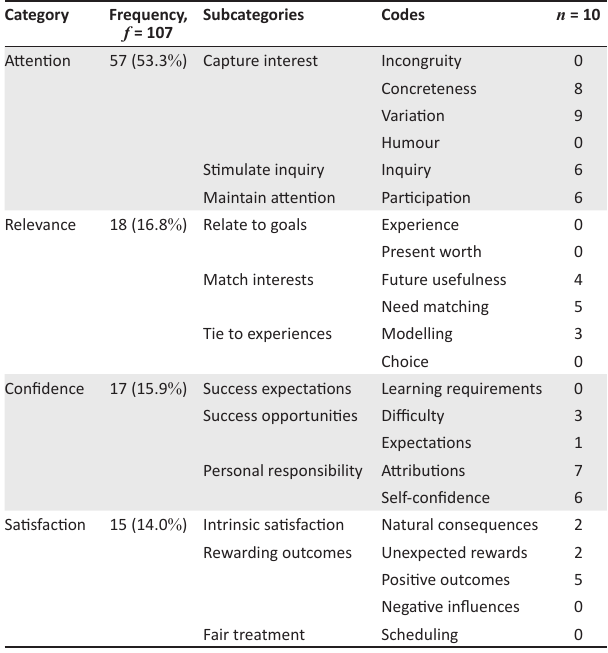
TABLE 1: Categories, subcategories and codes.